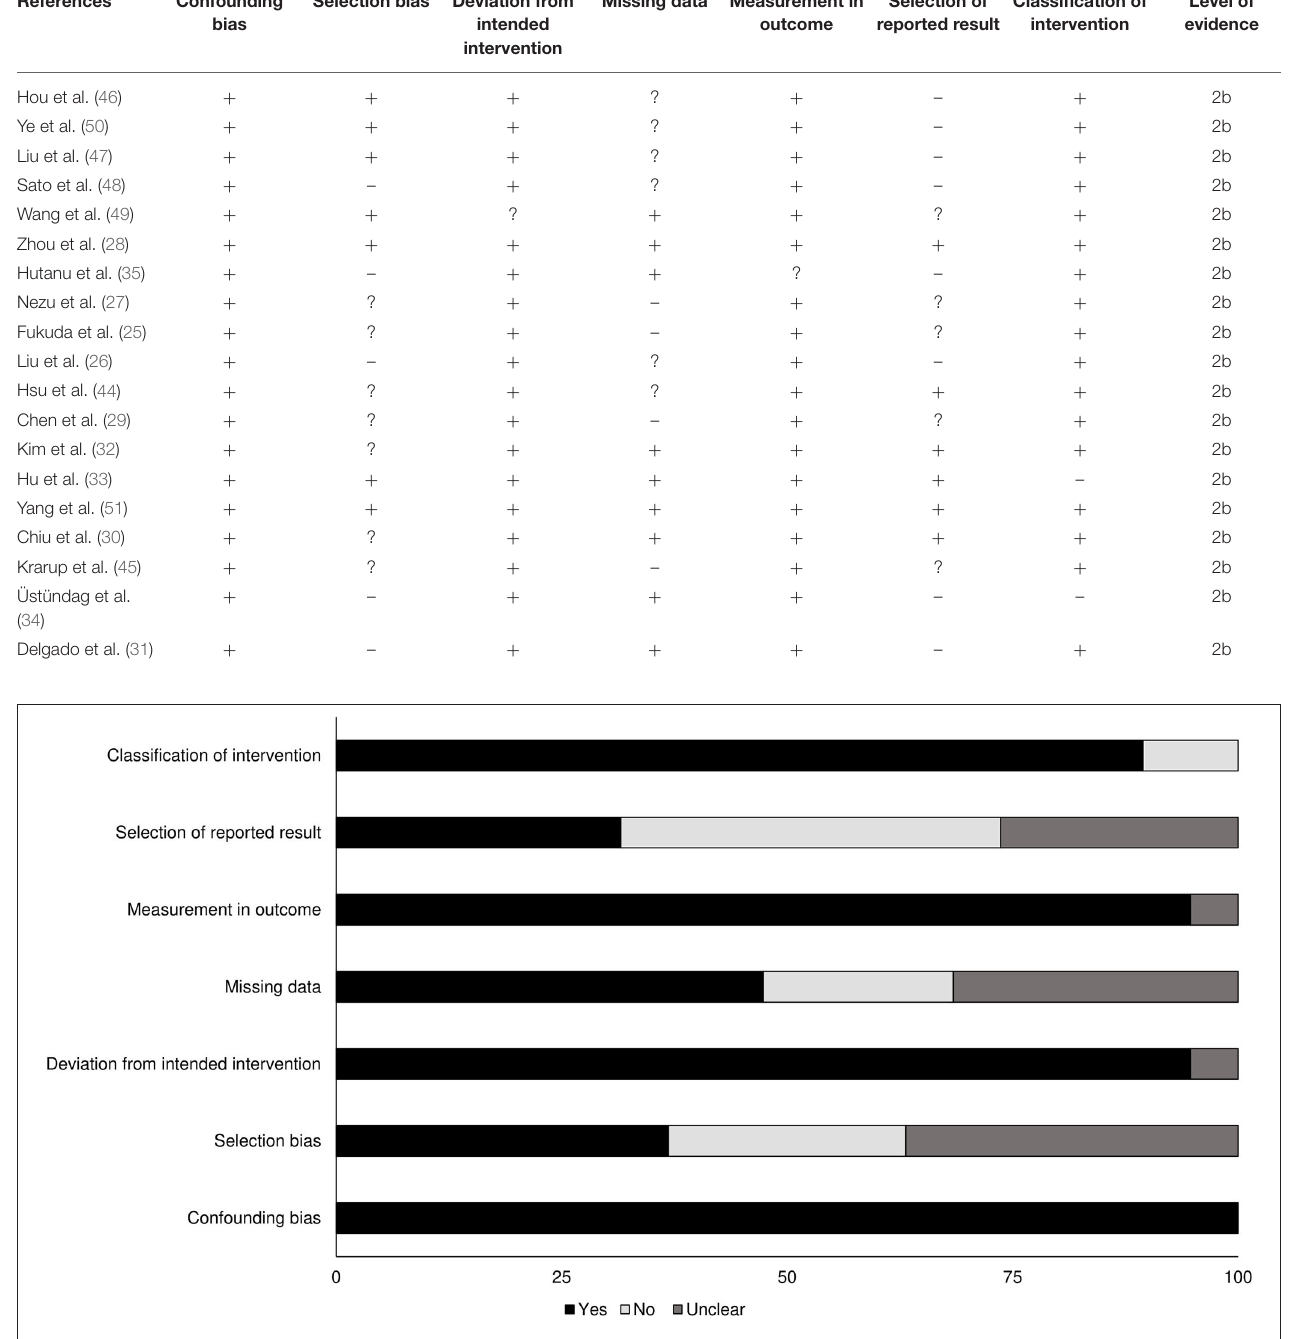
FIGURE 2 | Risk of bias for non-randomized controlled trials according to the Cochrane risk of bias